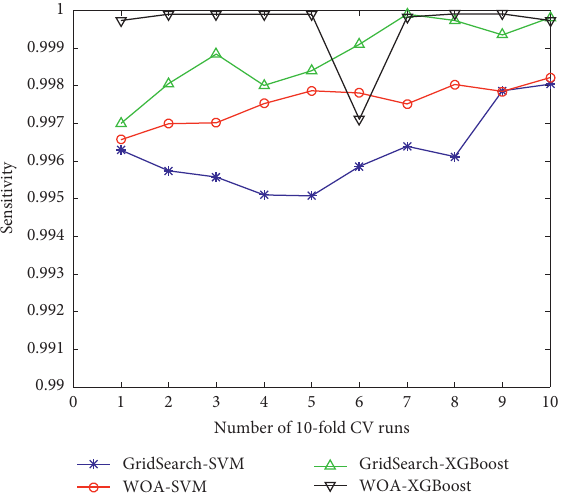
Figure 2: The sensitivity achieved at each run without feature selection.